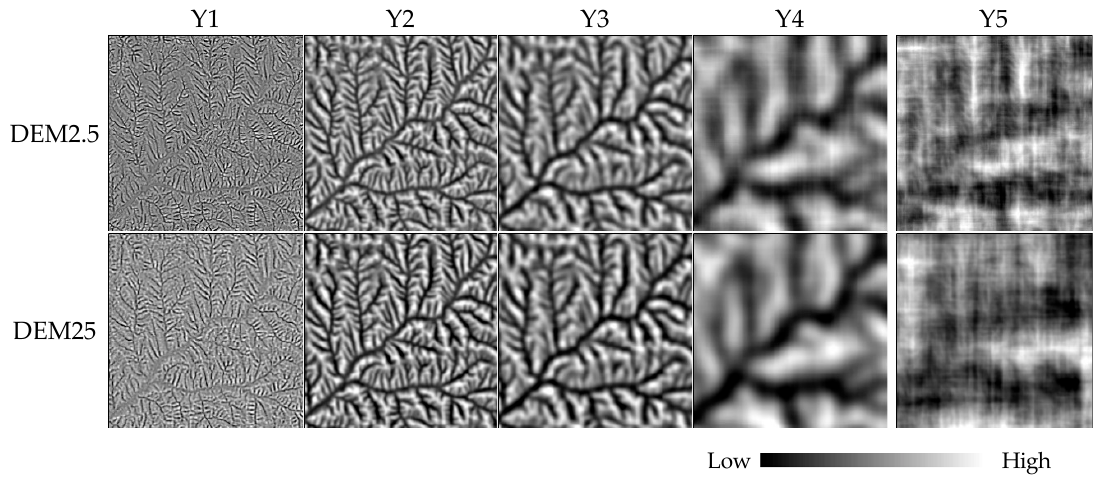
Figure 5. Surfaces of components at resolutions of 2.5 m and 25 m